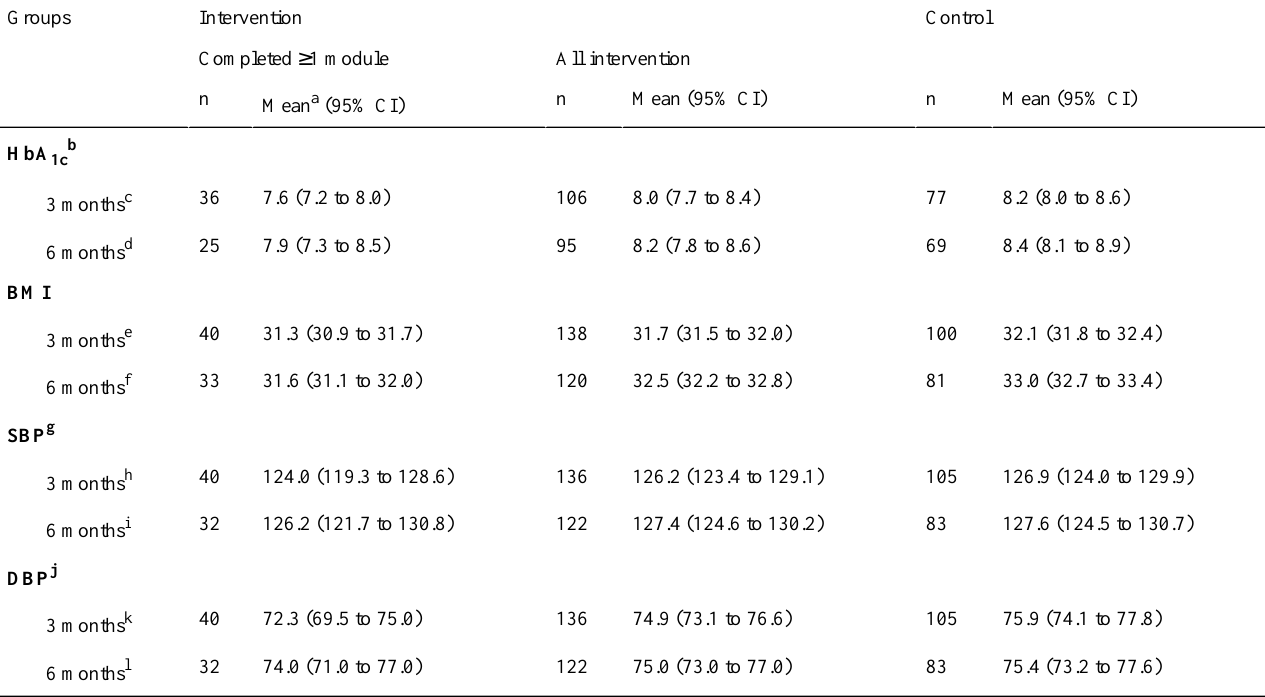
Table 5. Comparisons of baseline-adjusted health outcome means between groups at 3 and 6